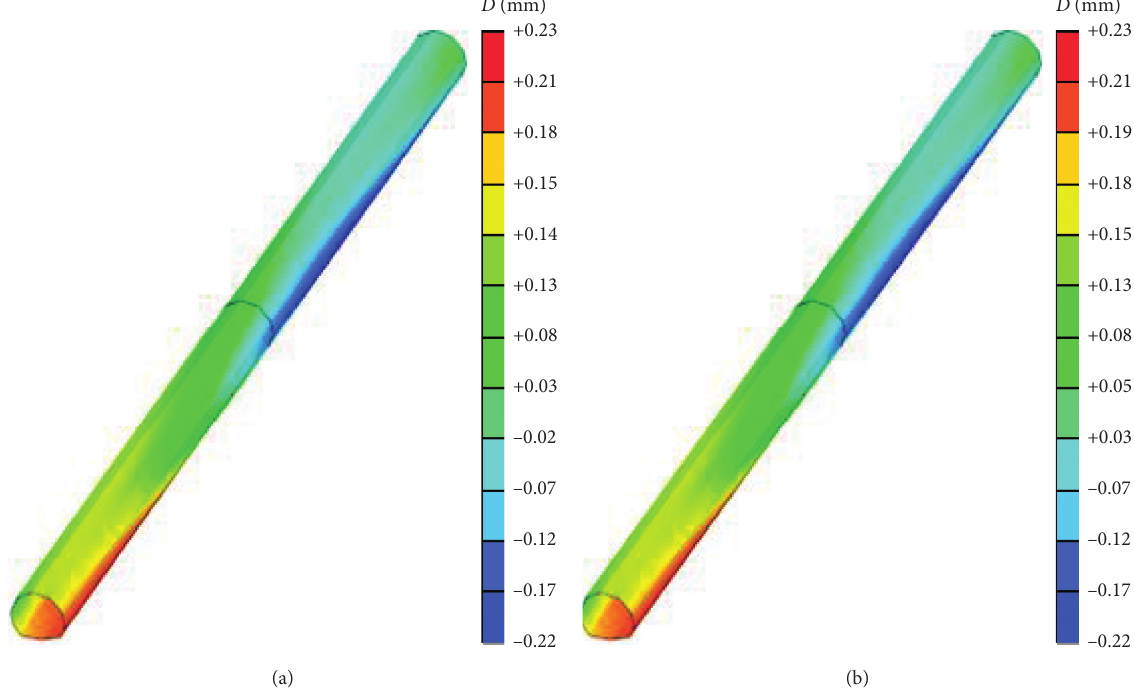
Figure 6: Cloud diagram of horizontal displacement of the existing tunnel lining. (a) Excavation program I. (b) Excavation program II.